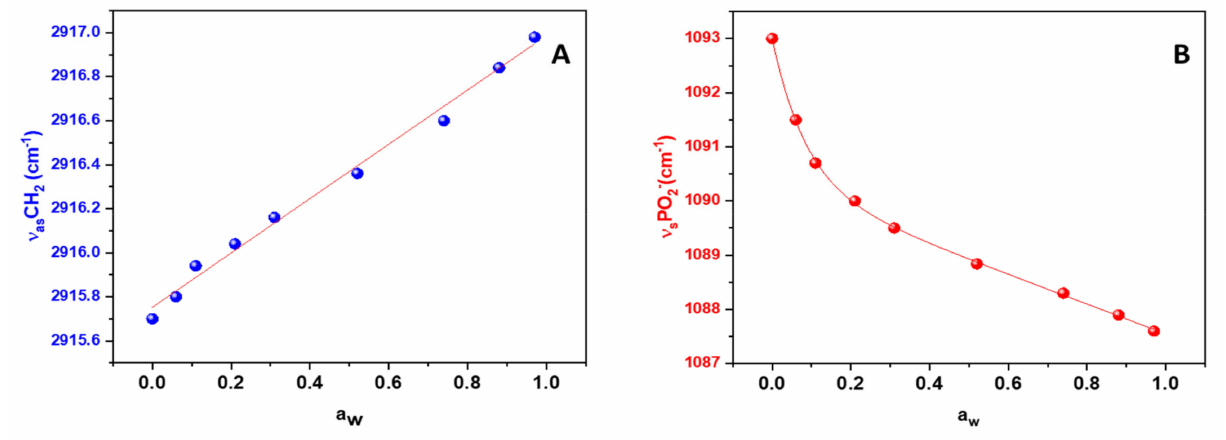
Figure 4. Correspondence of water activity with ( A ) ν CH 2 frequency, and ( B ) ν PO 2 − frequency at different water